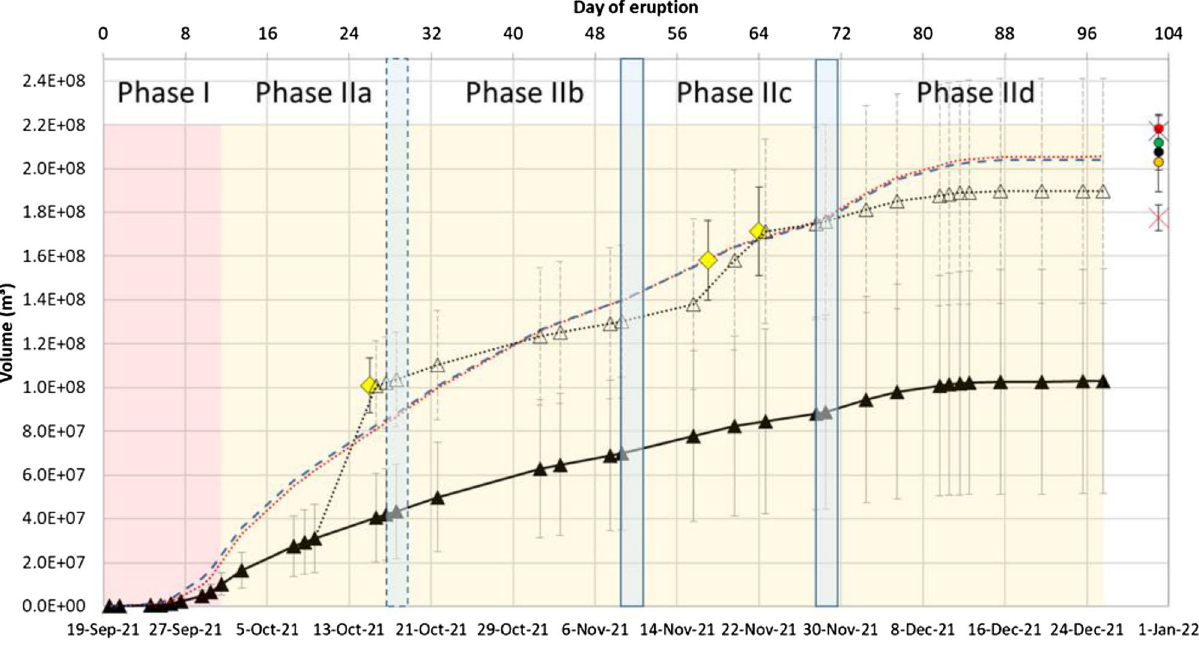
Figure 5. Lava volume evolution estimated from thermal data only (black filled triangles, same as Fig. 4), overlaid by calibrated thermal data-derived volume time series (open black triangles, black dotted line). TanDEM-X volume estimates (yellow diamonds) were used for calibrating the thermal volume time series. Our own final lava volume estimates by Pléiades tri-stereo DSM (green circle—CATENA, black circle—Agisoft Metashape). The blue dashed line simulates the original thermal data estimates but multiplied by a factor of 2. The red dotted line shows the thermal volume estimates when modelling an increased the silica content (cf. “Comparison of the different approaches” section). Copernicus EMS volume estimate based on Pléiades tri- stereo (February 3, 2022, red circle). Pléiades data-based volume estimates by 42 (orange circle). Post-eruptive drone data-based volume measurements by 47 are shown by the red cross (only lava) and black cross (lava and proximal fallout) (cf. “Comparison with independent measurements”